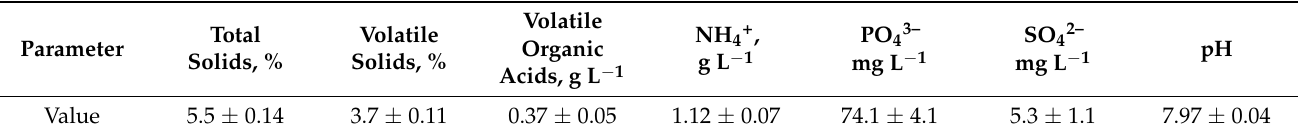
Table 1. Characteristics of an initial effluent from anaerobic biogas reactors.